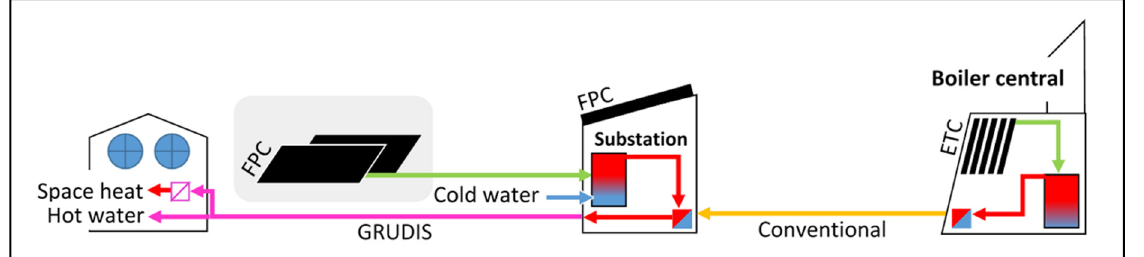
Figure 4. Hybrid distribution—Simple schematic of the hybrid heat distribution concept with boiler central (BC), intermediate substation, and single-family house. Roof and ground-mounted flat plate collectors (FPC), evacuated tube collectors (ETC) on boiler central [12].